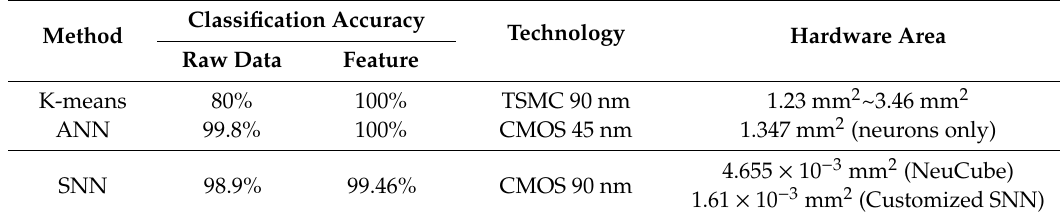
Table 8. Performance comparison of three methods in SHM application.